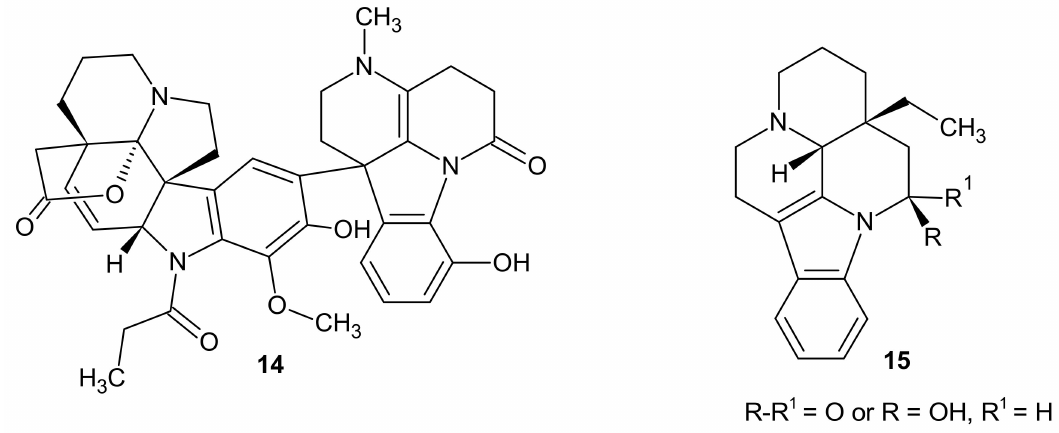
Figure 4. Structures of cimiciduphytine 14 and eburnane derivatives 15